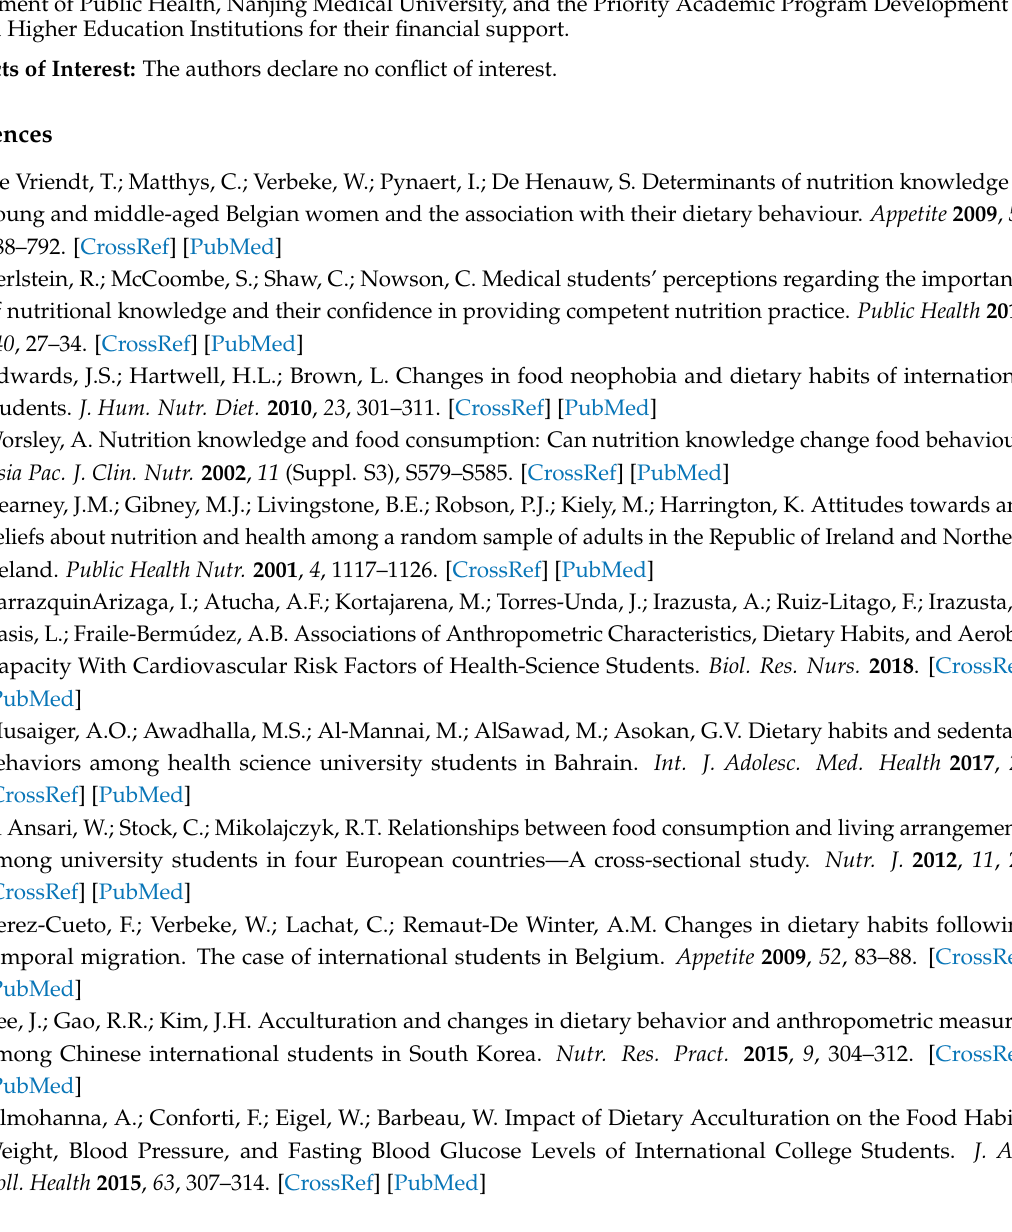
Table S1: Description of students according to their country, Table S2: Responses of international and Chinese